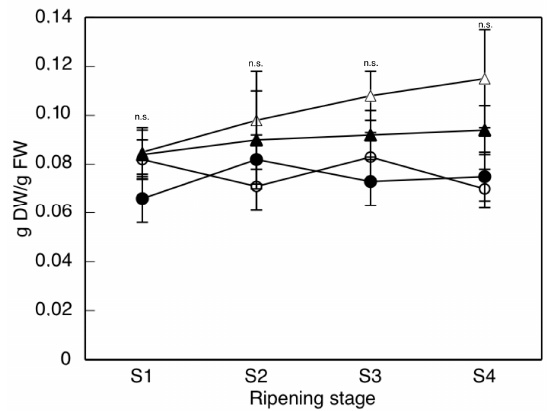
Figure 2. The DW/FW ratio at different stages of ripening. Treatments: ( ● ) rainfed without thinning (H1), ( ○ ) rainfed with thinning (L1), ( ▲ ) irrigated without thinning (H2), and ( △ ) irrigated with thinning (L2). The data are the means ± SD of at least 10 replicates obtained from 5 different experiments. According to Friedman test, no significant differences are indicated by n.s. Table 1. Total phenols, flavonoids, and phenylpropanoid glycosides in the different treatments and ripening stages used. Data are the means ± SD of at least 10 replicates obtained from 5 different experiments. The values were subjected to the Friedman test.